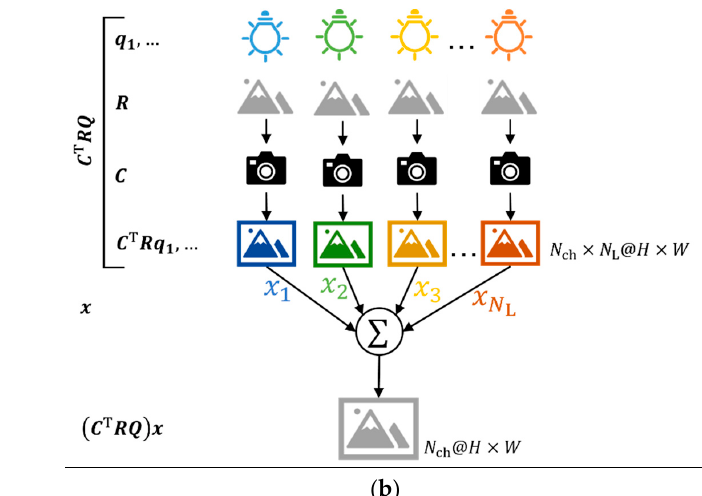
Figure 1. The observed features: ( a ) The image was measured under the accumulated (mixed) spec- tral power distribution (SPD) of sub-SPDs with the intensities of 𝒙 = (cid:3427)𝑥 (cid:2869) ,…,𝑥 (cid:3015) (cid:3144) ] . ( b ) Images were measured for each sub-SPD, then synthesized into one image by multiplication with the linear weights, 𝒙 . Equivalence was achieved between the case observed under the accumulated spectral power distribution (SPD) and a linear synthesized variant of the observed features under each sub- SPD. Considering that the observed features that were measured under the accumulated SPD ( = (𝑪 (cid:2904) 𝑹𝑸)𝒙 ) and the synthesized features, after measuring under the sub-SPDs ( = 𝑪 (cid:2904) 𝑹(𝑸𝒙) ), are the same, from Equation (3), the images in ( a ) and ( b ) are the same if lighting weights, 𝒙, are the same as each other and measuring the images by camera has linearity.